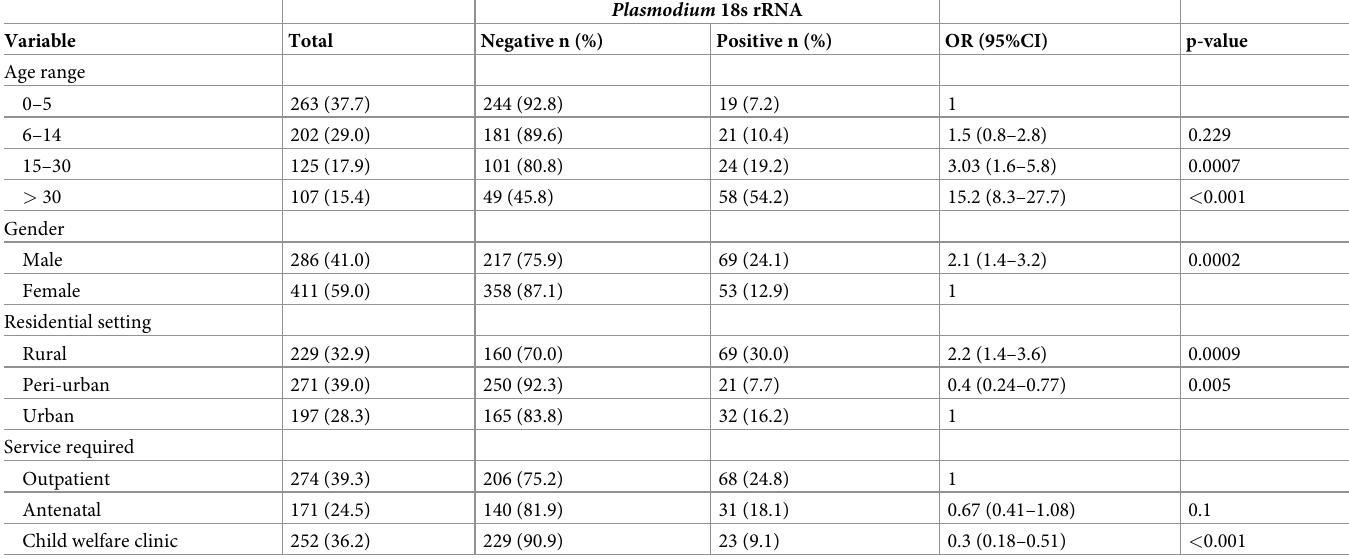
Table 2. Demographical features of the study participants and their association with Plasmodium 18s rRNA status.